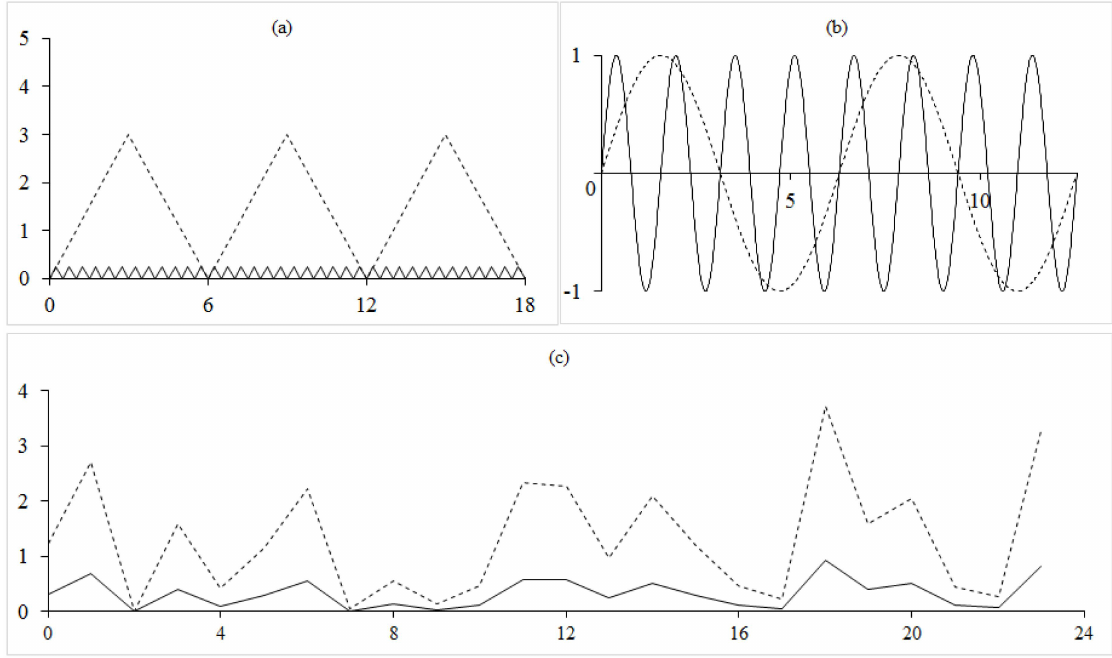
Figure 6. Processes for special case. ( a ) the zigzag processes; ( b ) the sine/cosine processes; ( c ) similar processes with different scale of